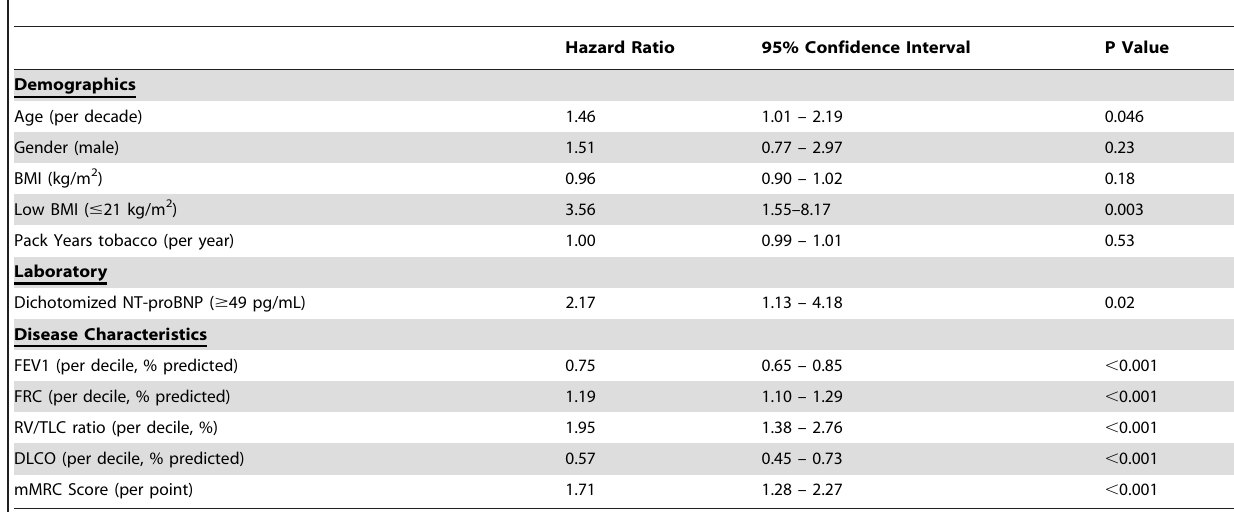
Table 3. Clinical Variables and Mortality in Univariate Proportional Hazard Survival Analysis.